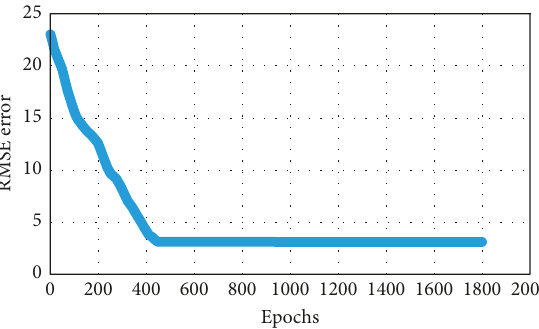
Figure 4: Training data process between input and target data based on the RMSE error for deflection of RC deep beams (280 input-output